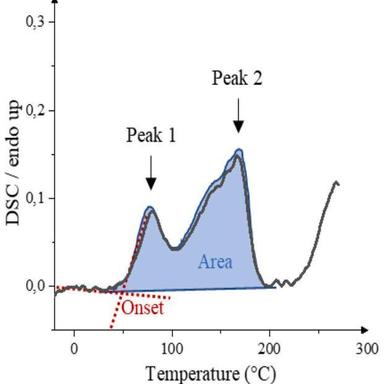
Illustration of temperatures and peak area used for statistical analysis.